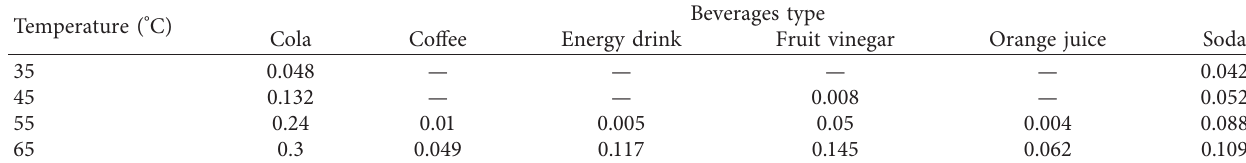
Table 1: The intensity ratio of GHB/GBL in beverages after pretreatment under different temperature. Temperature ( °